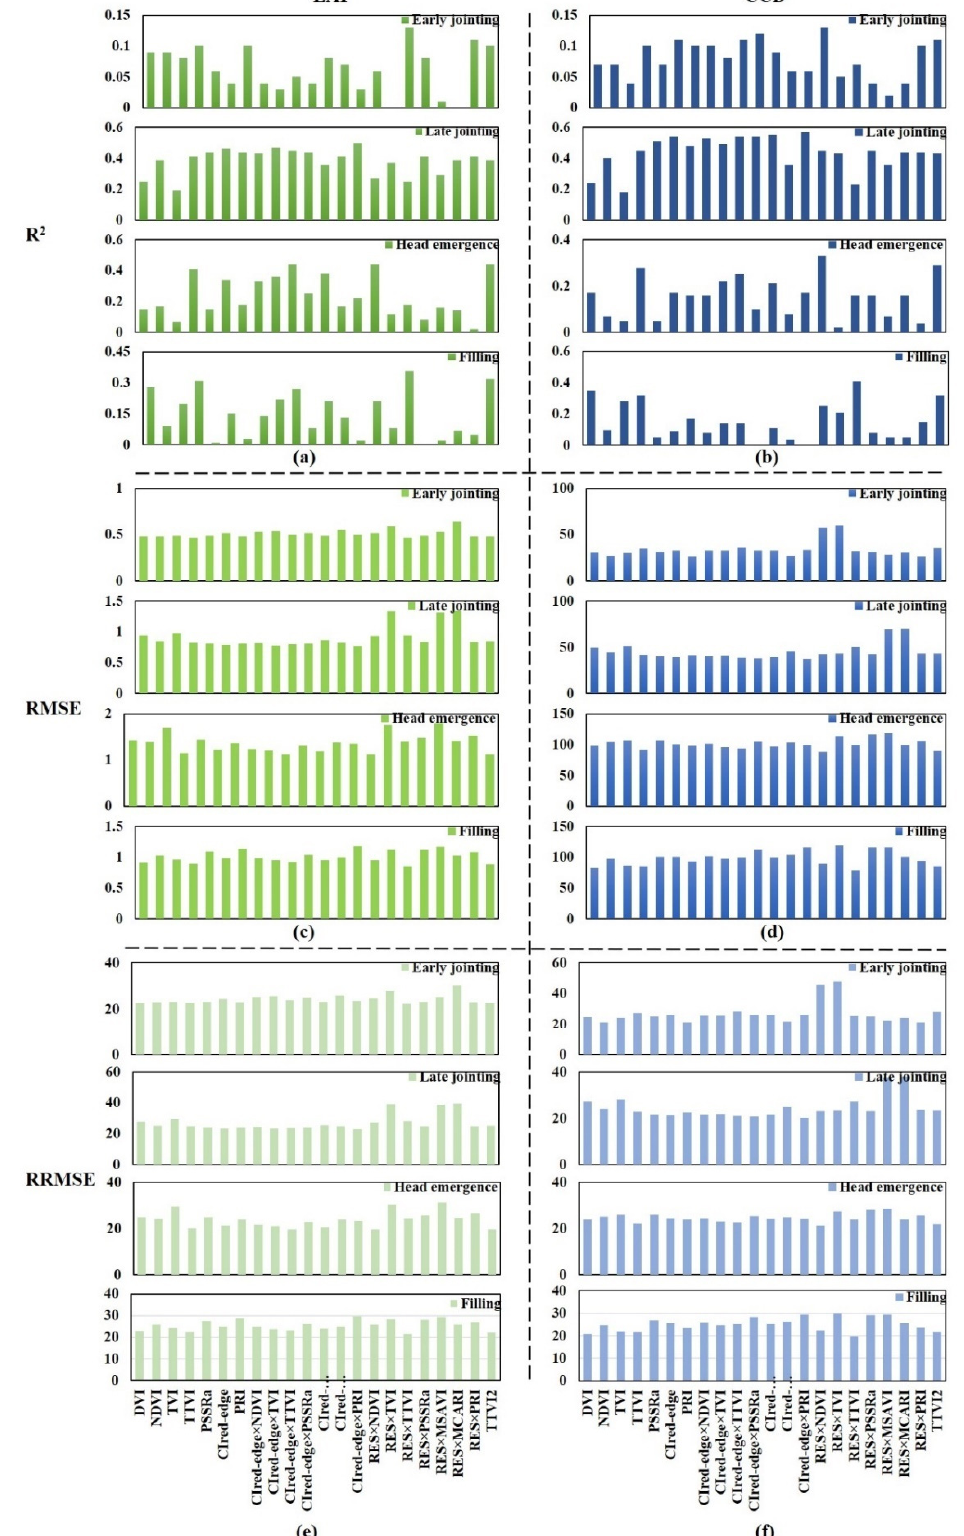
Figure 6. The estimation results for LAI and CCD at different growth stages. Figures ( a , c , e ) show the R 2 , RSMSE, and RRMSE results between VIs and LAI; ( b , d , f ) are the corresponding results between VIs and CCD.